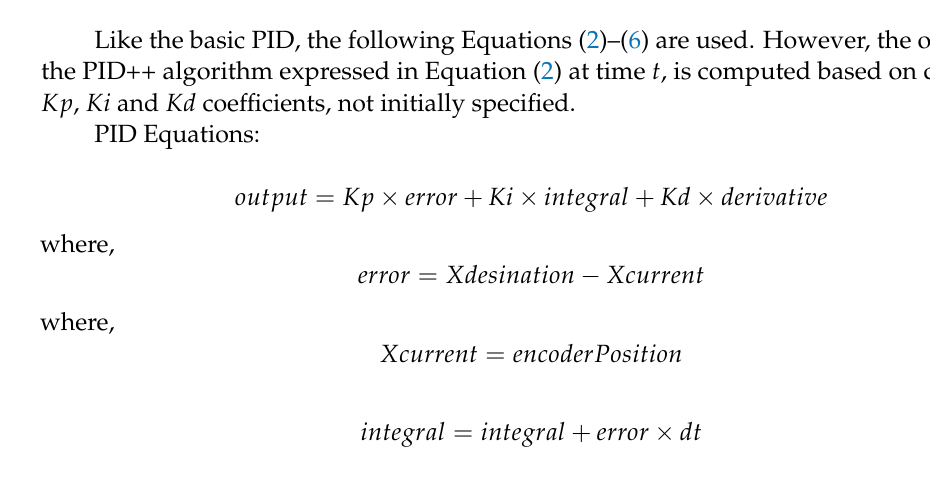
Figure 3. ( a ) PID++ control block diagram. ( b ) PID++ Flow Chart—Main